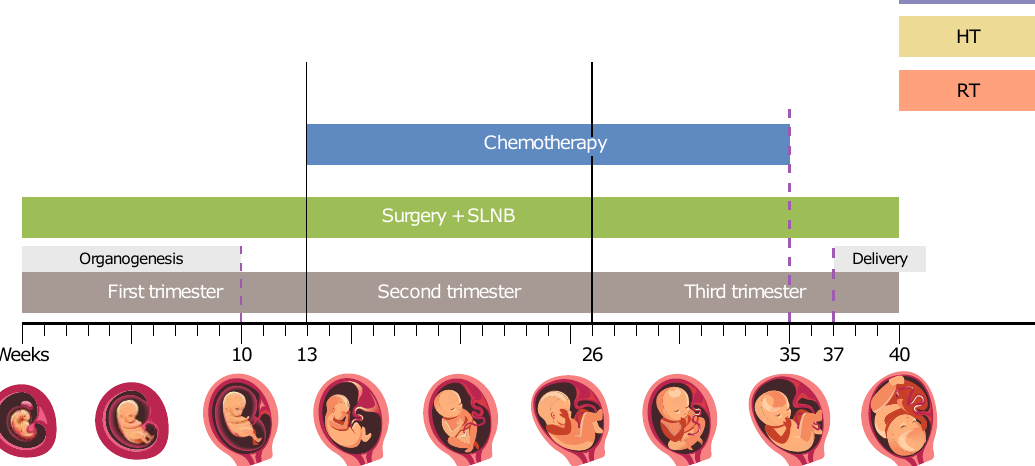
Figure 2. Recommended time line for various anti-neoplastic modalities. Surgery is potentially safe at all phases. Chemotherapy is recommended from week 14 (to allow a ’safe period’ after organogenesis) and should be discontinued around week 35 until after delivery to avoid myelosuppression at time of delivery. Hormonal therapy (HT), radiation therapy (RT), and targeted therapy (anti-HER2) should be postponed until after delivery. SLNB—sentinel lymph node